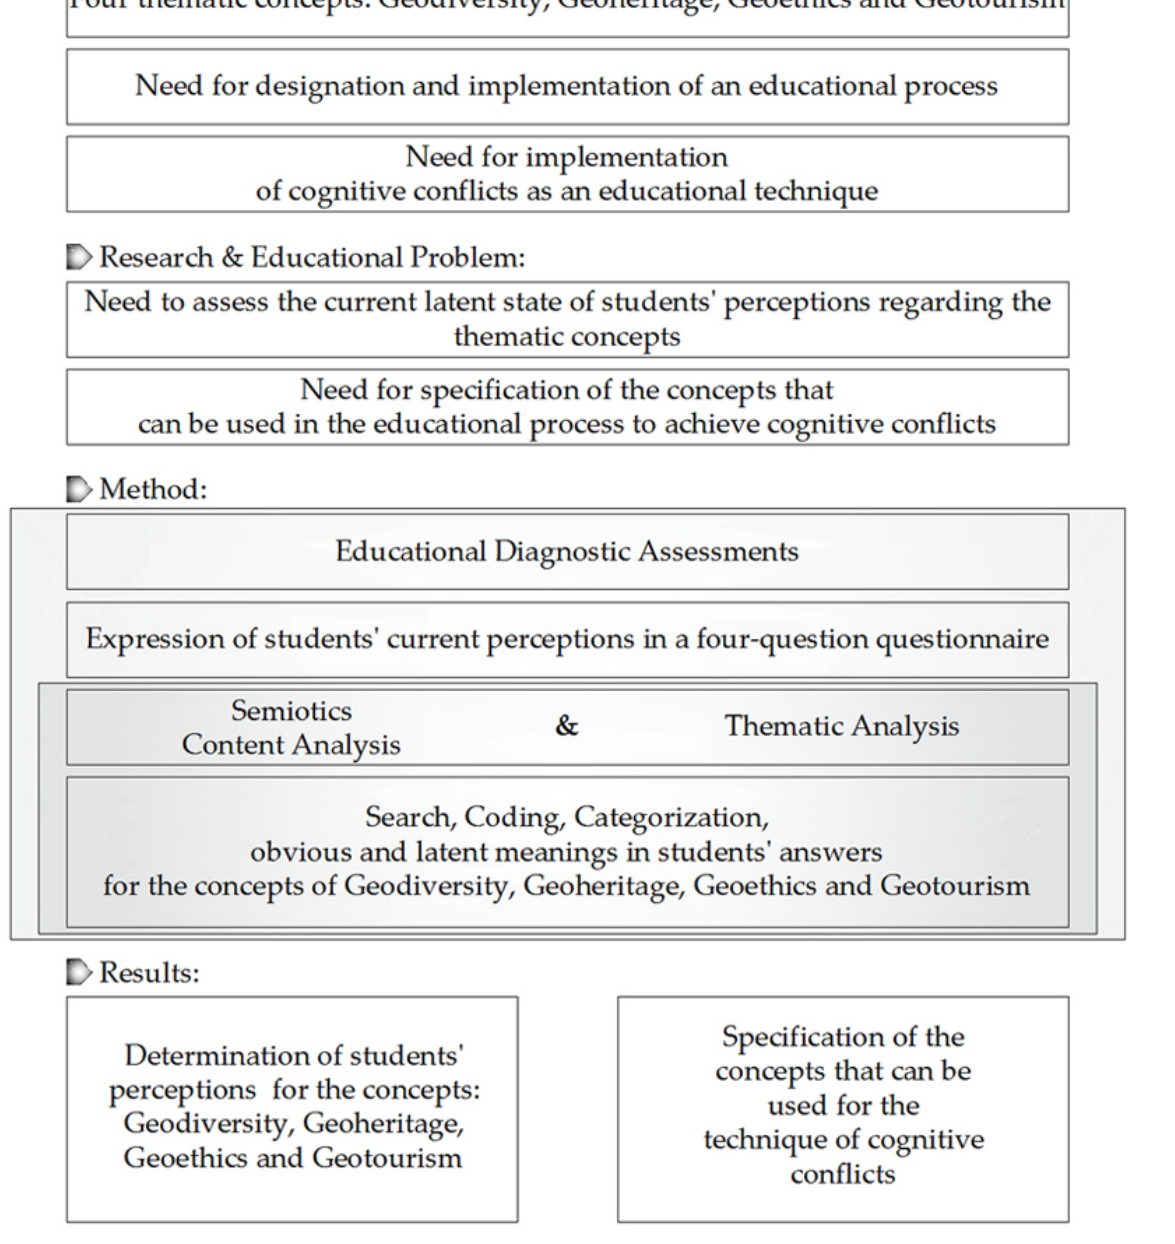
Figure 1. Context and methodology for answering the research questions.